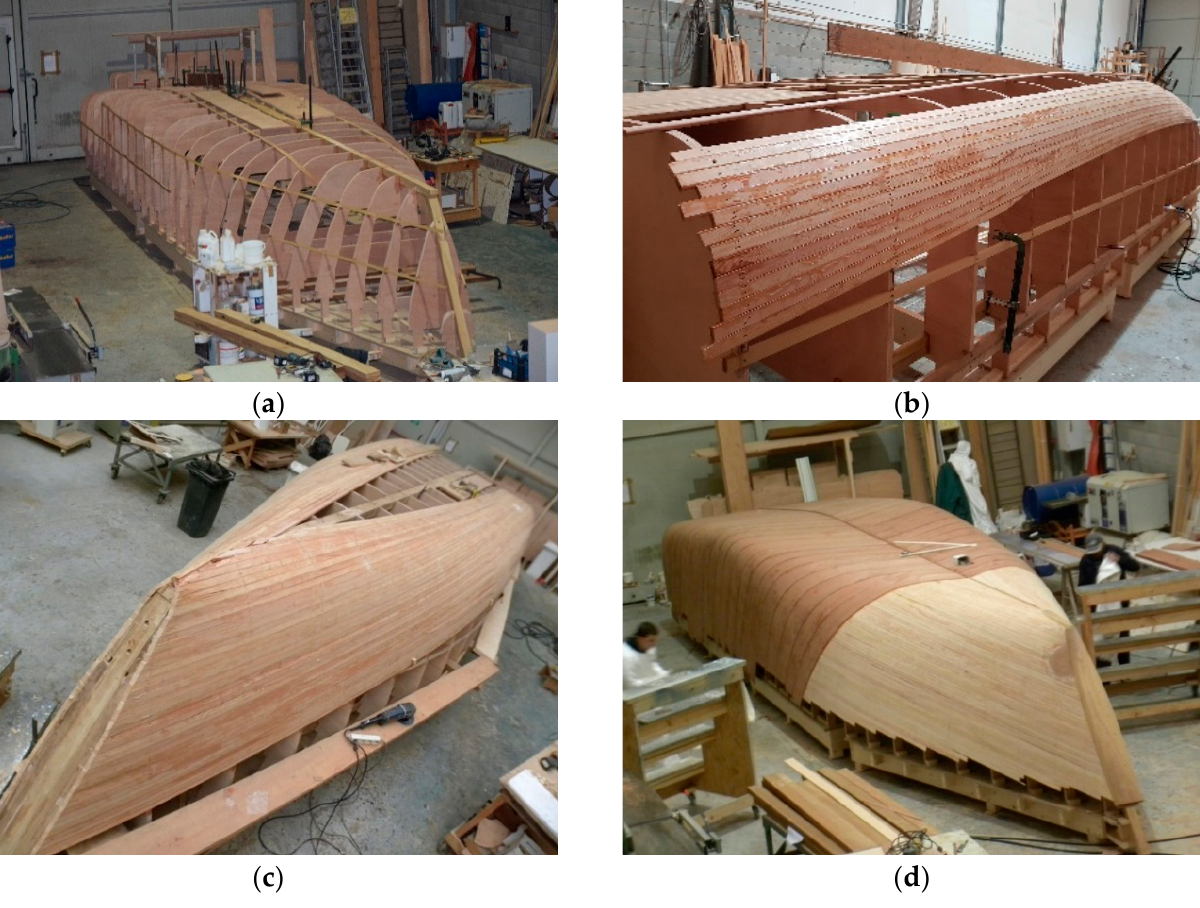
Figure 11. Phases of the construction of a strip-planked hull [96]. (a) transversal frames. (b) and (c) wood strips. (d) wood veneers